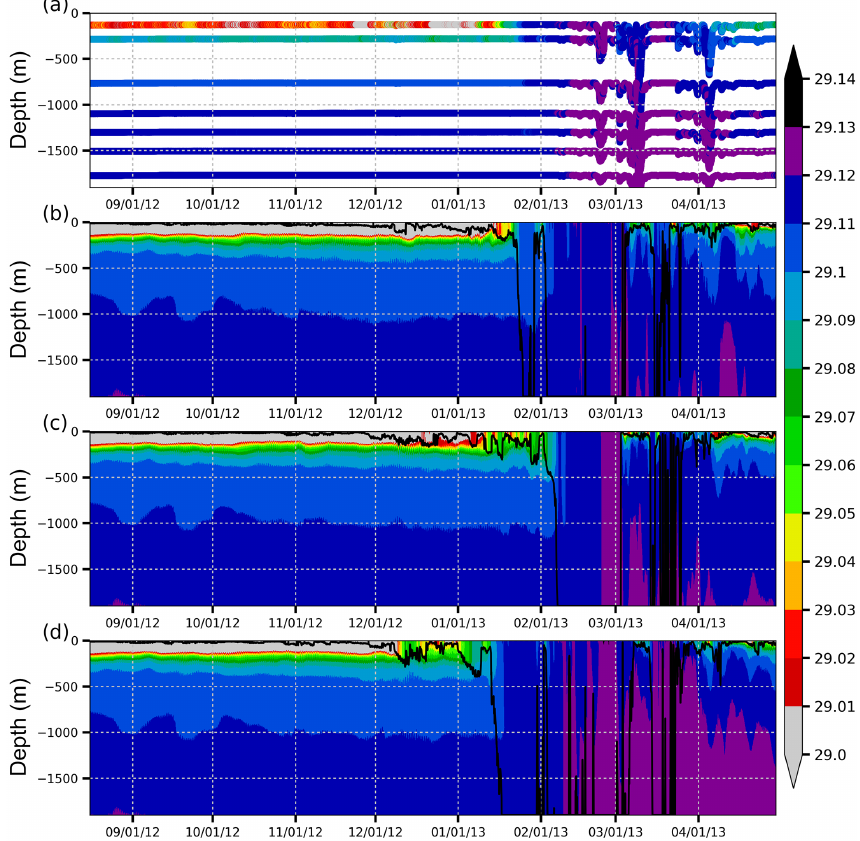
Figure 11. Time series of 0–2000m sea water density (a) observed at the LION mooring and computed for each simulation (b) COARE, (c) ANDREAS and (d) MOON at the LION mooring location. The black line correspond to mixed layer depth (computed with a density criterion of 0.01kgm 3 ). Dates are indicated in mm/dd/yyyy format.